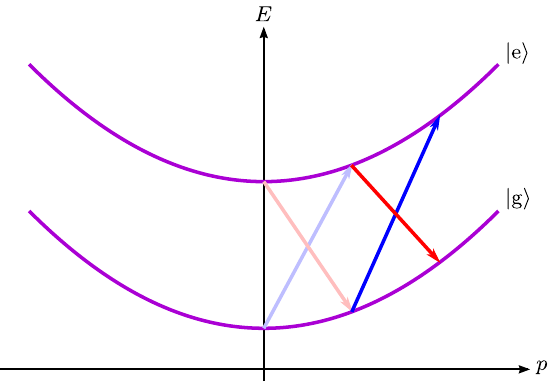
FIG. 15. If one shifts the frequencies of the two counter- propagating beams by 3 ω and − 3 ω , one can resonantly rec rec address the diffracted atoms in Fig. 14 with an additional single- photon momentum transfer in the same direction while swapping the internal states again. When simultaneous π pulses with these frequencies are applied right after the simultaneous π = 2 pulses of Fig. 14, the net result is to leave the internal states unchanged but generate an equal-amplitude superposition, as far as the c.m. motion is concerned, of an undiffracted wave packet and a diffracted one with a total momentum transfer ℏ k correspond- eff ing to twice the single-photon